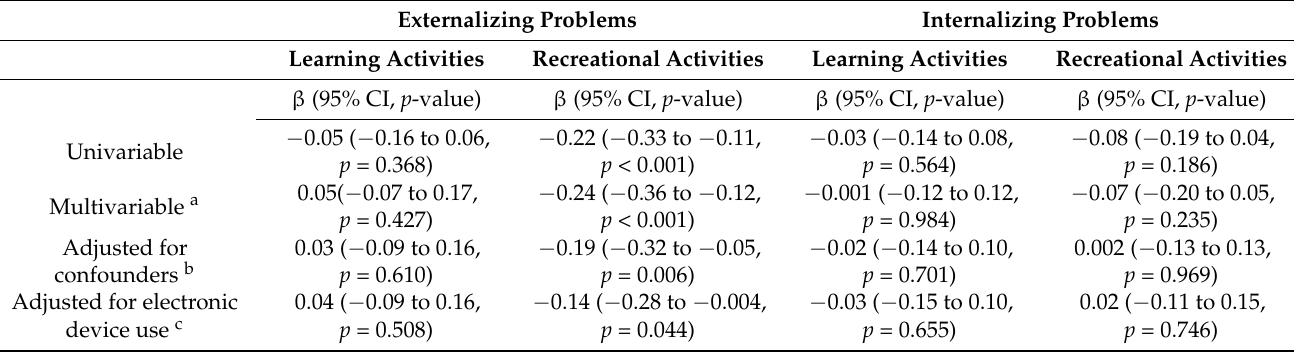
Table 4. Effect of specific parent–child activity type on later externalizing and internalizing